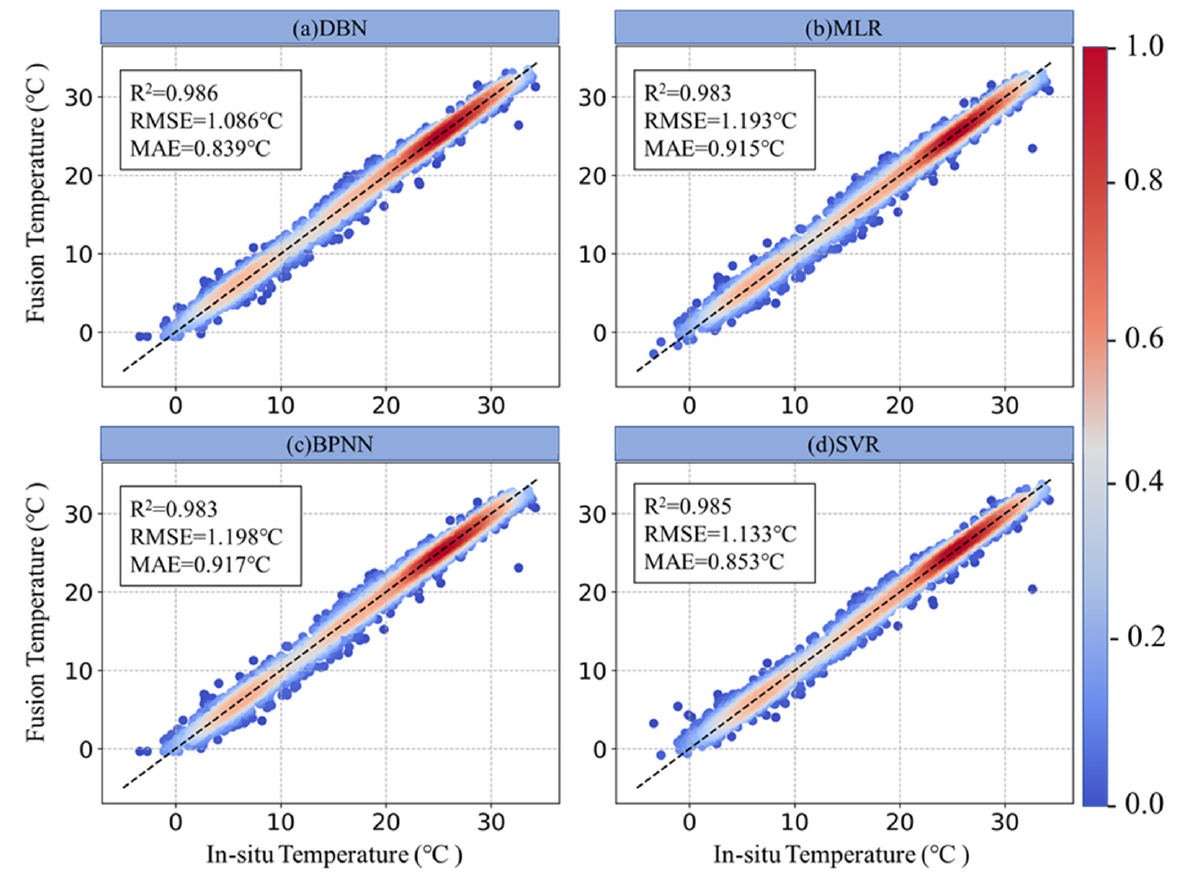
Figure 5. The density scatter plots of the in-situ temperature and 3H air temperature for the cross- validation results. ( a – d ) represent the results for DBN, MLR, BPNN and SVR models, respectively. The x and y axes represent in-situ ground measurements and fusion temperature, respectively. The red color represents dense concentration of scatters.